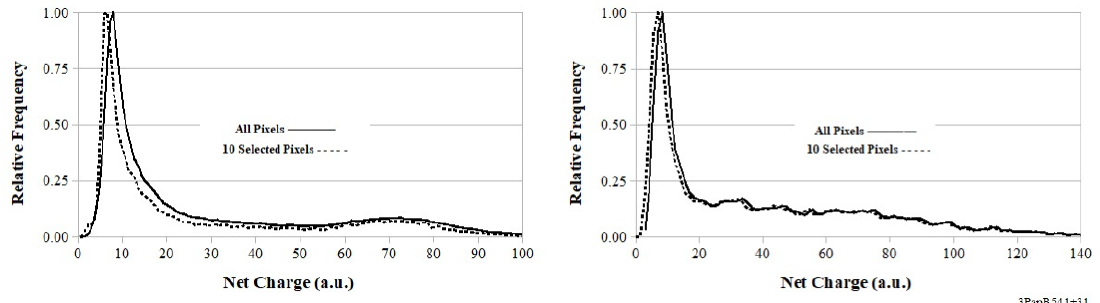
Figure 11. Cs-137 ( left ), and Lu-176 self-activity ( right ) data: comparison between the pulse-height spectra from All pixels and the ones from the respective selected decuples of pixels. Spectra were normalized to the respective maximum values.